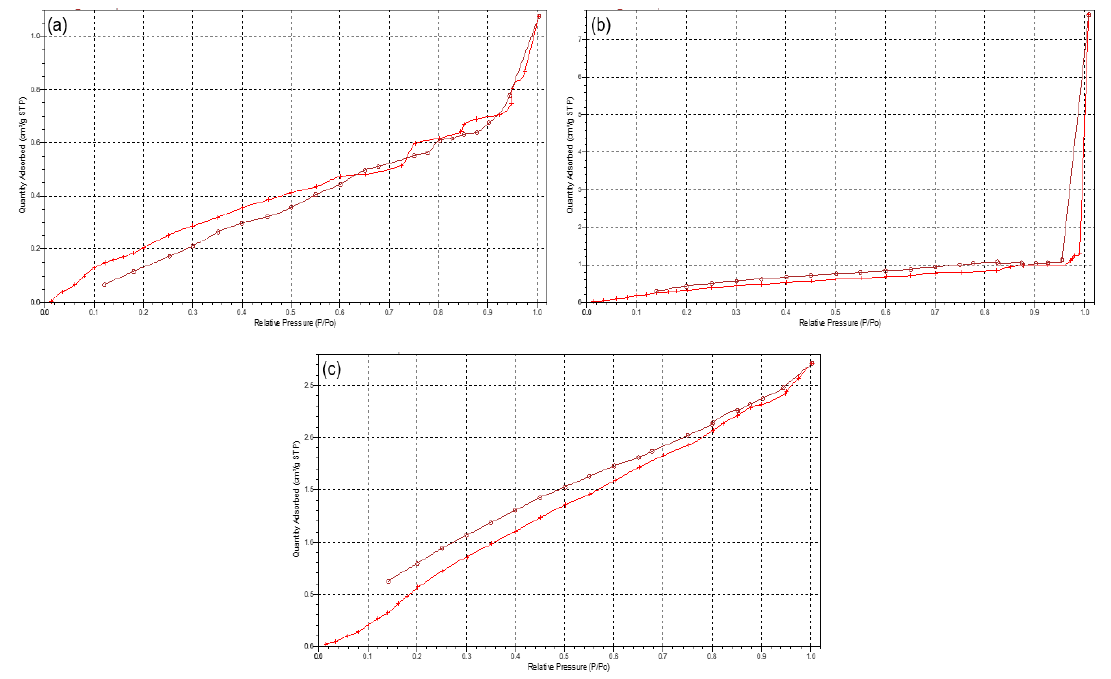
Figure 5. Typical isotherms of ( a ) PCL 10 , ( b ) PCL 80 , and ( c ) 3D printed PCL blend.